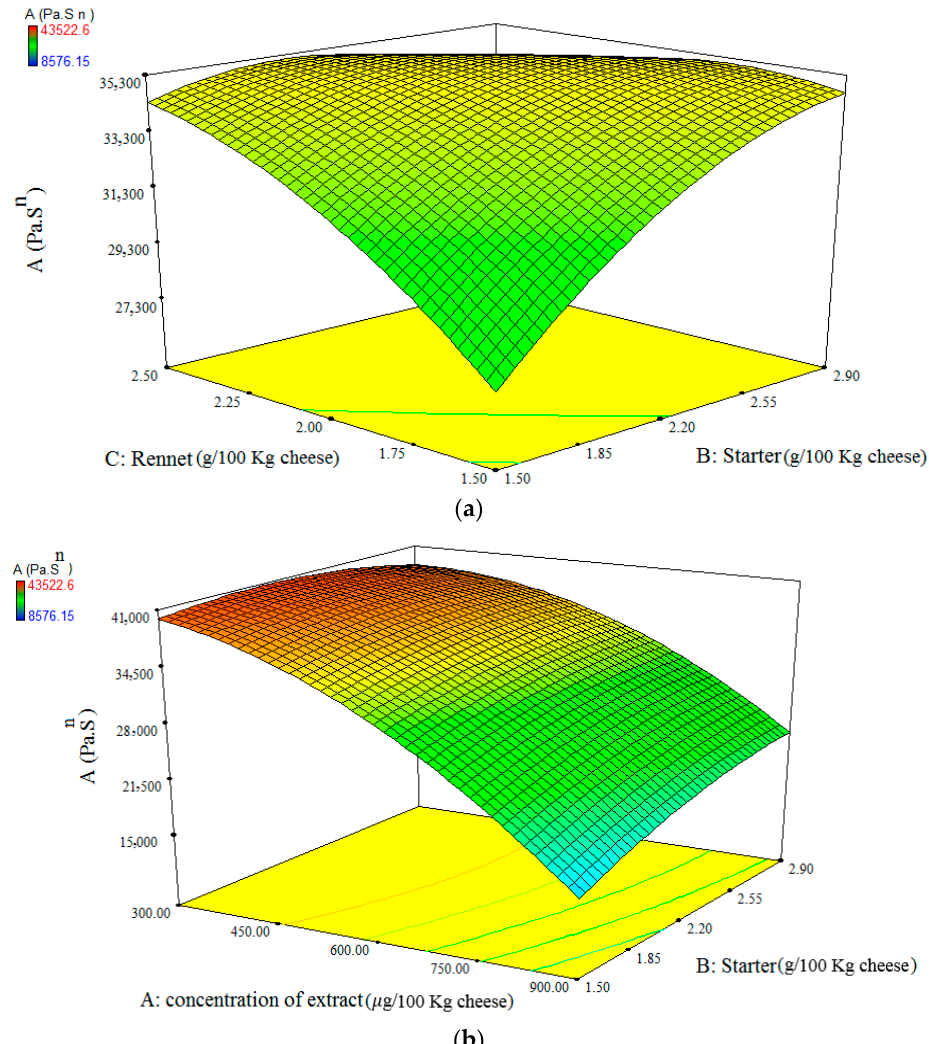
Figure 2. The surface response plot of the interactions of rennet and starter concentrations ( a ) and extract and starter concentrations ( b ) on the strength of the linkage parameter (A, Pa·s 1/z ) of SBL- extract-added cheese.